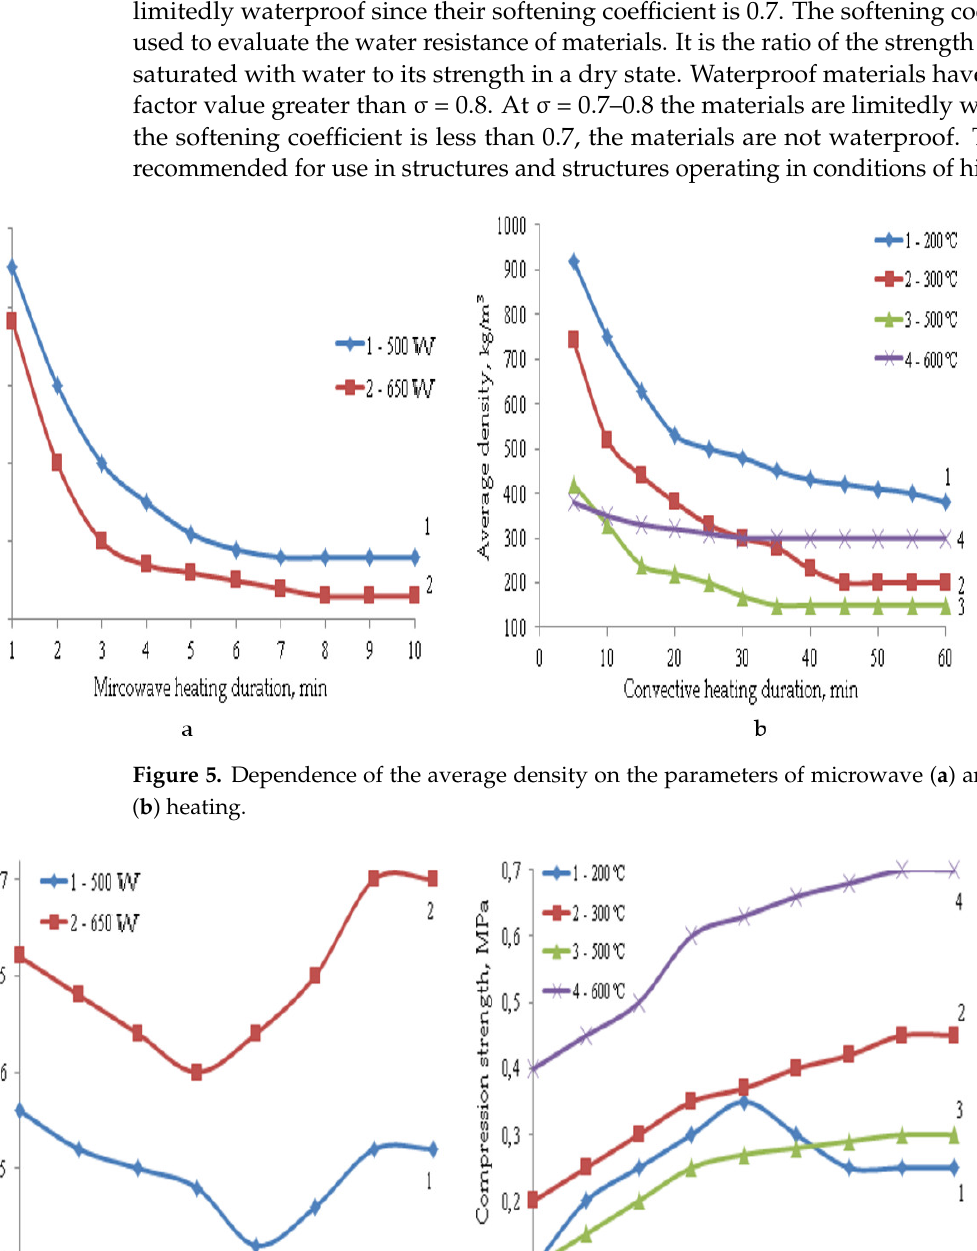
Figure 6. Dependence of compression strength on the parameters of microwave ( a ) and convective ( b ) heating.